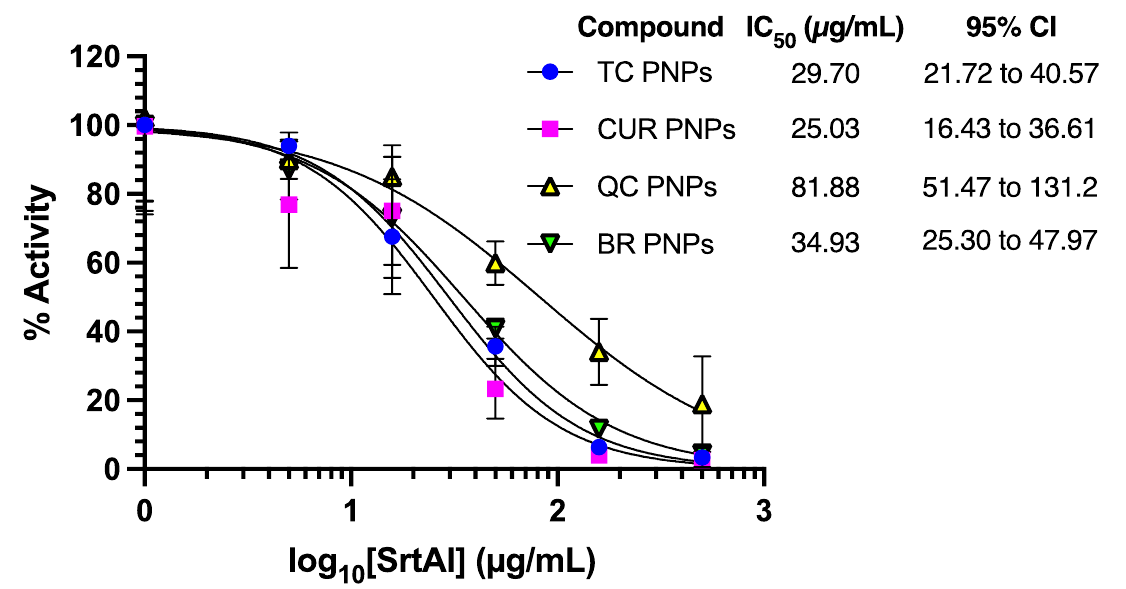
Figure 4. Calculated IC 50 values ( µ g/mL), 95% confidence intervals (CIs), and dose-response curves for each SrtAI (BR, CUR, TC, QC) PNP formulation against SrtA ΔN59 as determined using a FRET- based readout. Results represent the mean ± SD for three independent experiments, with data fitted to a sigmoidal curve model using GraphPad Prism.